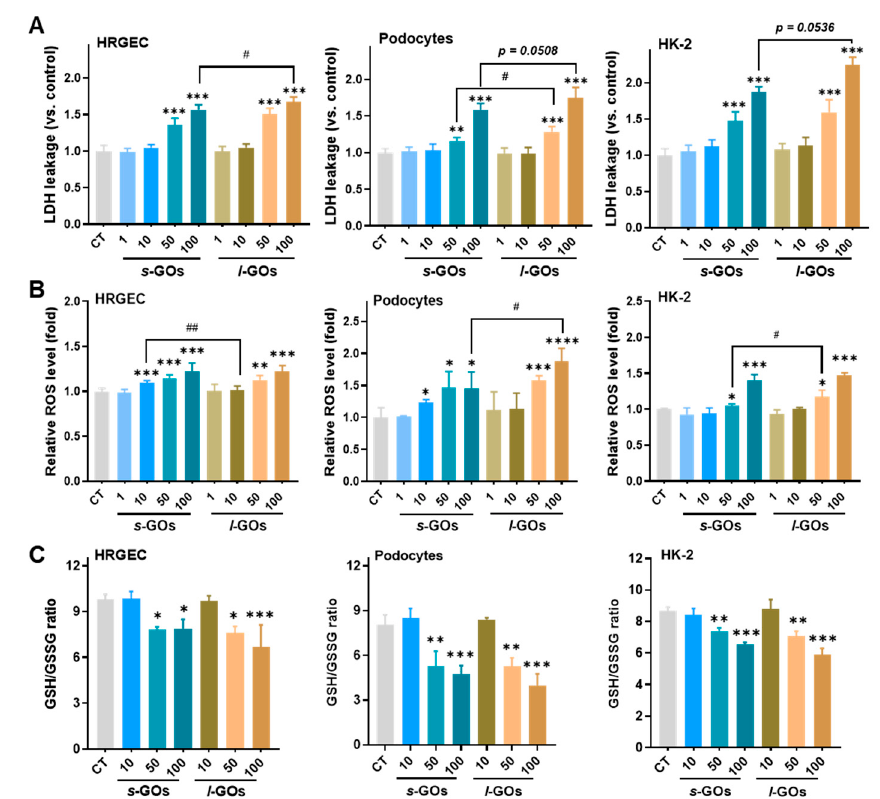
Figure 5. ( A ) LDH leakage in HRGECs, podocytes, and HK-2 cells was determined after cells were treated with s -GOs and l -GOs for 24 h. ( B ) The intracellular ROS levels were caused by 2 h of s -GO and l -GO treatments. ( C ) GSH/GSSG ratios in HRGECs, podocytes, and HK-2 cells after 2 h treatments with s -GOs and l -GOs. * p < 0.05, ** p < 0.01, *** p < 0.001, and **** p < 0.0001 for GO − treated group vs. the control group; # p < 0.05 and ## p < 0.01 for s -GO − vs. l -GO − treated